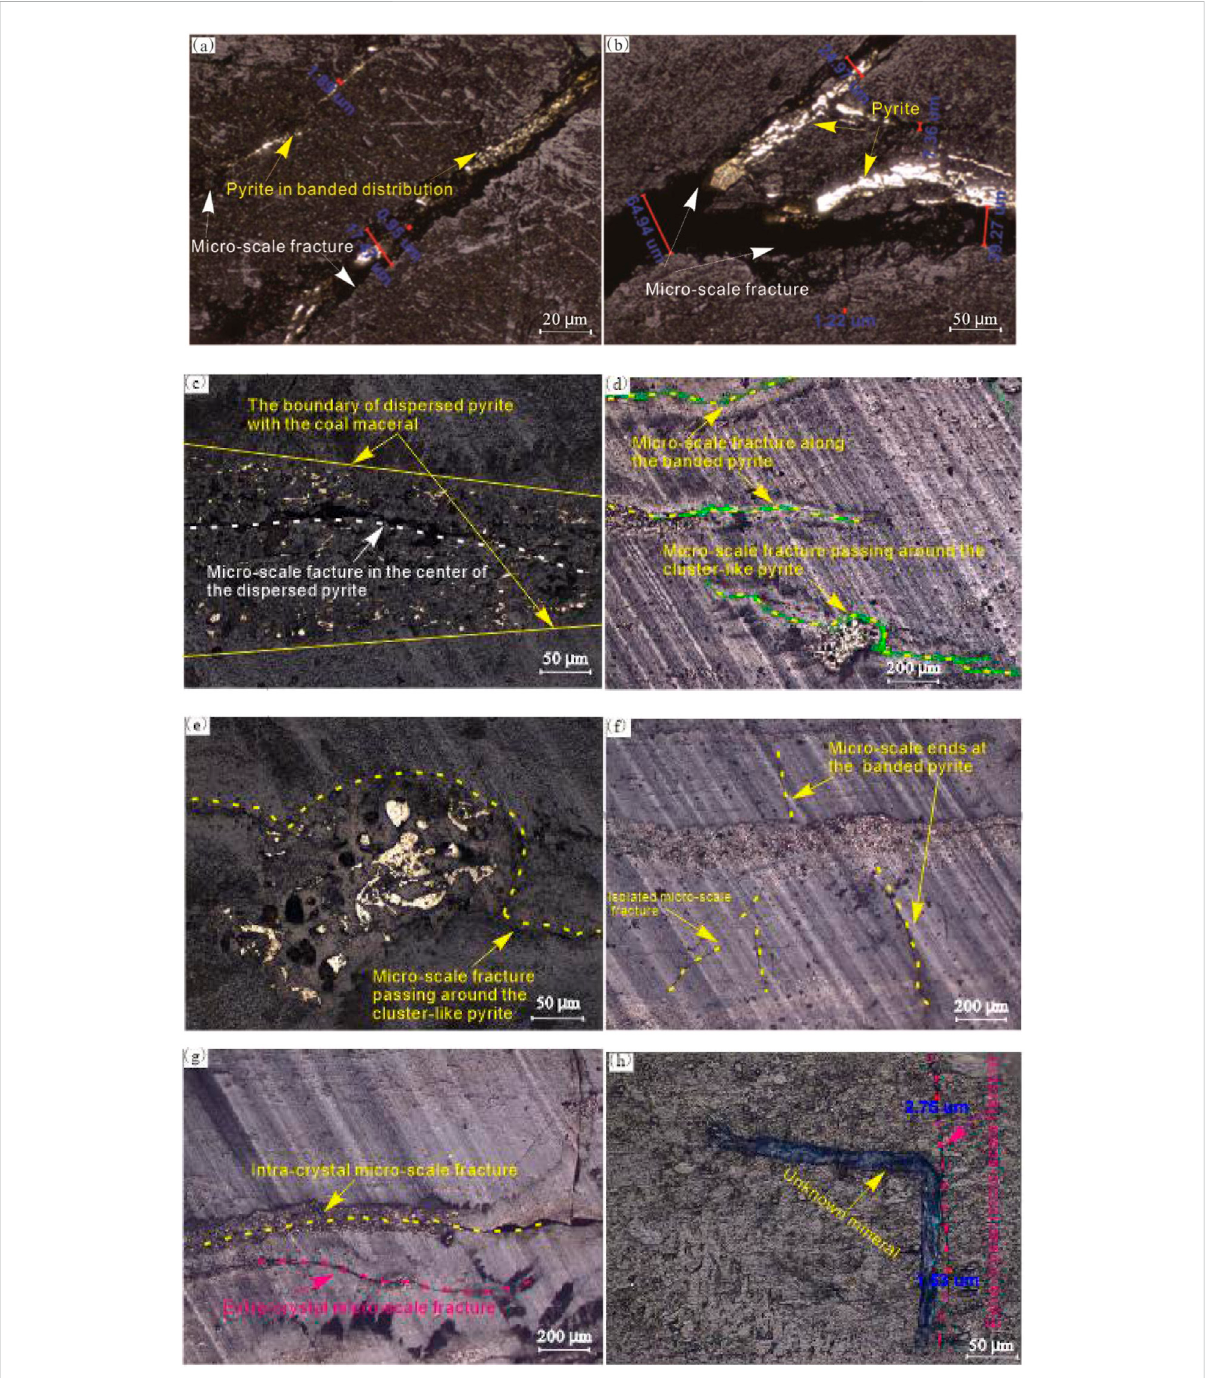
FIGURE 7 Micro-fracturestotheinorganicmetallicmineral: (A) ,micro-fracturesextendingalongthebandedpyrite; (B) ,micro-fracturesbifurcatedbythe adjacentbandedpyrite; (C) ,micro-fracturesextendingalongthecenterofthedispersedpyrite; (D) ,micro-scalefracturesextendingaroundtheedge ofthecluster-likepyriteparticles; (E) ,200-foldmagni fi cationoftheFigure7D; (F) ,micro-fracturesextendingperpendiculartothebandedpyrite; (G) , micro-fractures extending along the center of the banded pyrite; (H) , micro-fractures extending along with the banded mineral (unknown mineral).